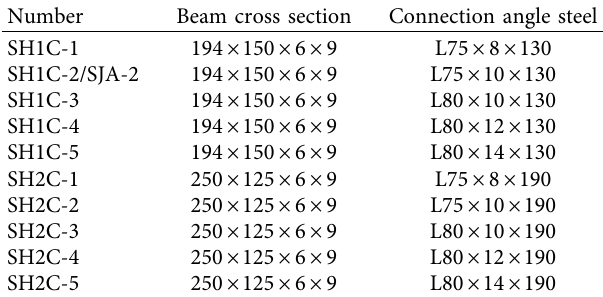
Table 8: Dimensions and information of the angular thickness series model